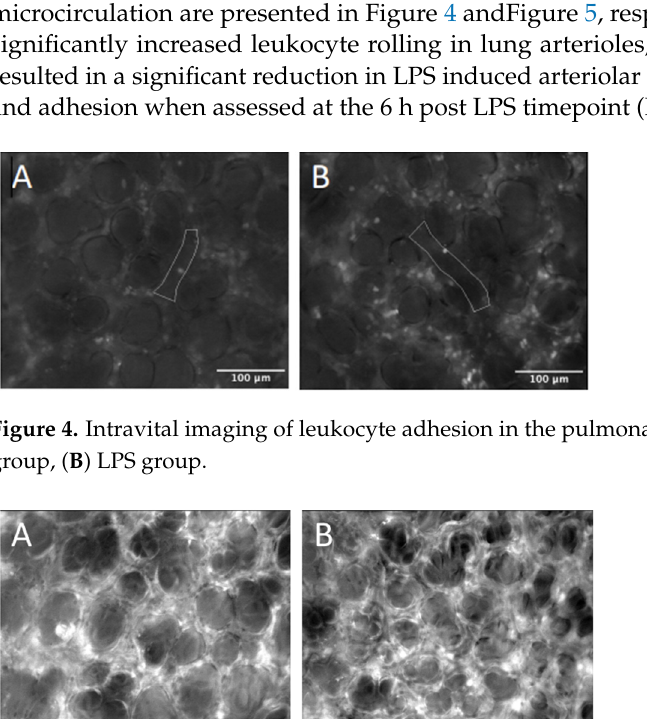
( A ) ( B ) ( C ) Figure 6. DIBI reduces leukocyte rolling and adhesion and improves capillary perfusion in the pul- monary microcirculation following intranasal LPS challenge in mice. Leukocyte–endothelial C O N L P S L P S + D I B I 0 200 400